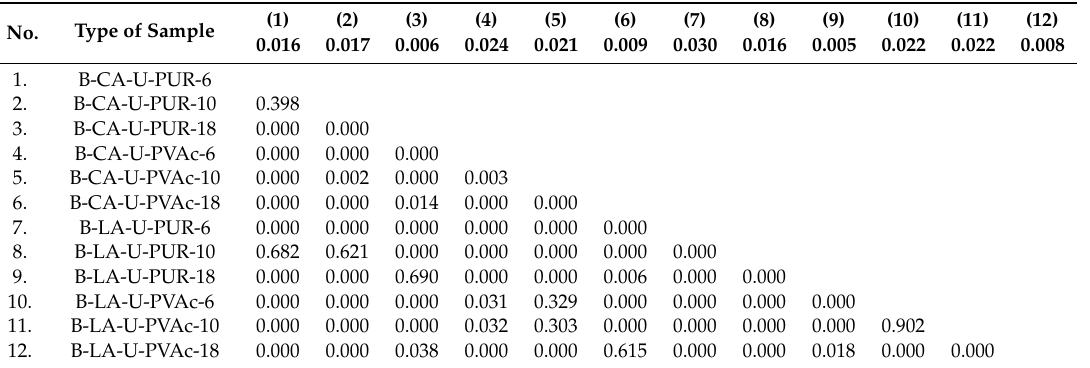
Figure 5. K bendC in case of beech. The situation was similar with beech lamellas (Figure 5). The greatest K bendC values were found in the beech samples with a 6 mm thickness, but unlike the aspen lamellas, no significant differences were found when different types of non-wood components were used. As with aspen lamellas, the lowest K bendC values were measured in lamellas with a thickness of 18 mm. The lamella thickness affected the bending coefficient. In beech samples, there was one extreme in the case of lamellas with